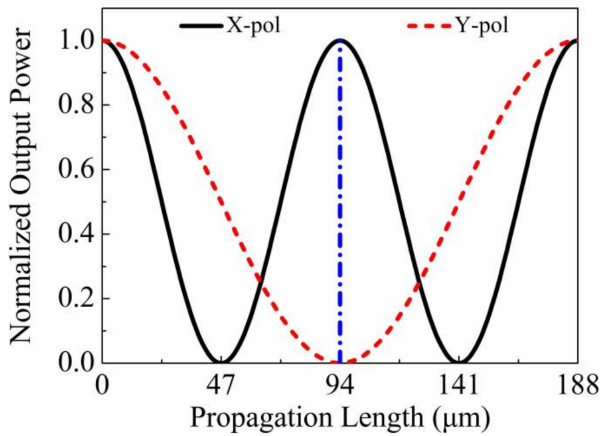
Figure 13. The relationships between the X-pol and Y-pol P out in the core A of the proposed LC-DC- PCF PBS and the L P at 1.604 µ